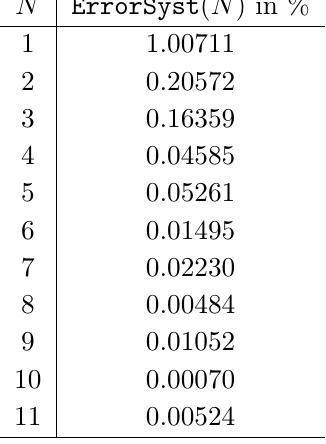
Table 2 . Systematic error in % attributed to each FO-approximant defined in eq.